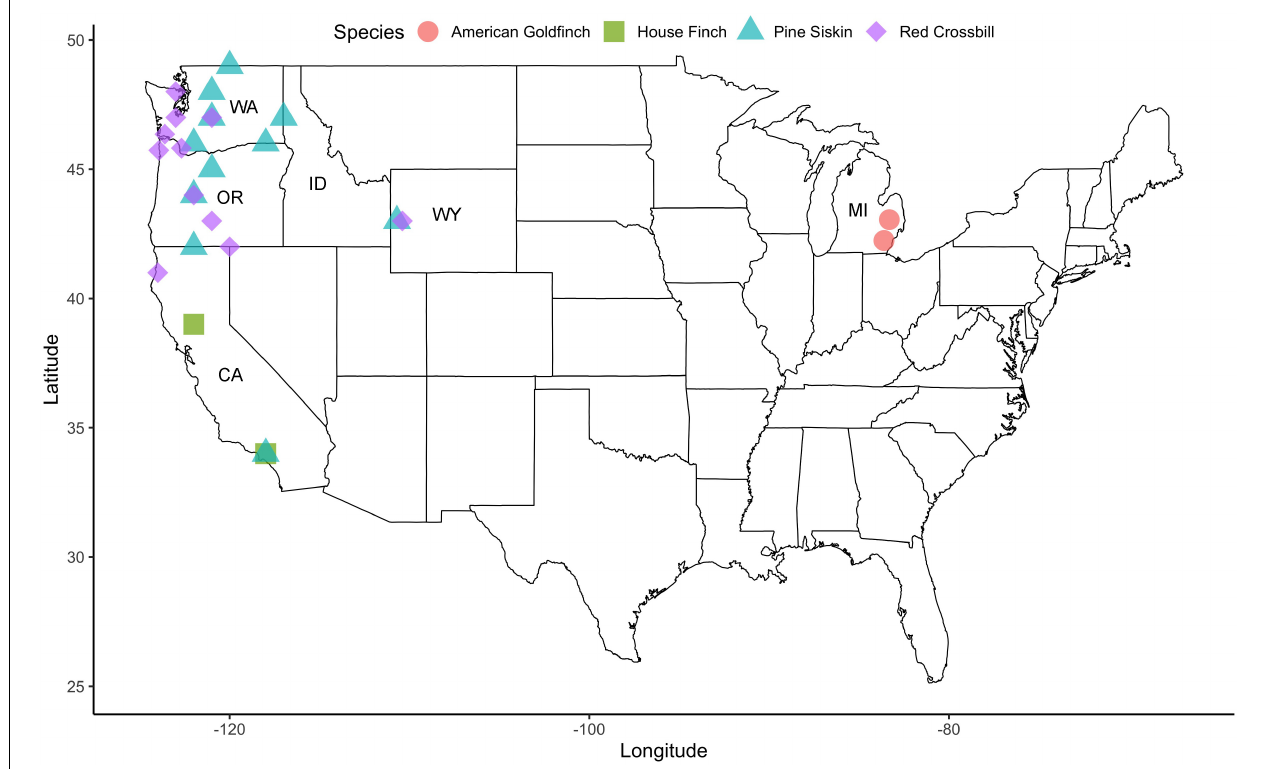
FIGURE 1 | Map of main capture locations for each study species in the United States of America. State borders are shown with states where birds were captured labeled (WA, Washington; OR, Oregon; CA, California; ID, Idaho; WY, Wyoming; MI,